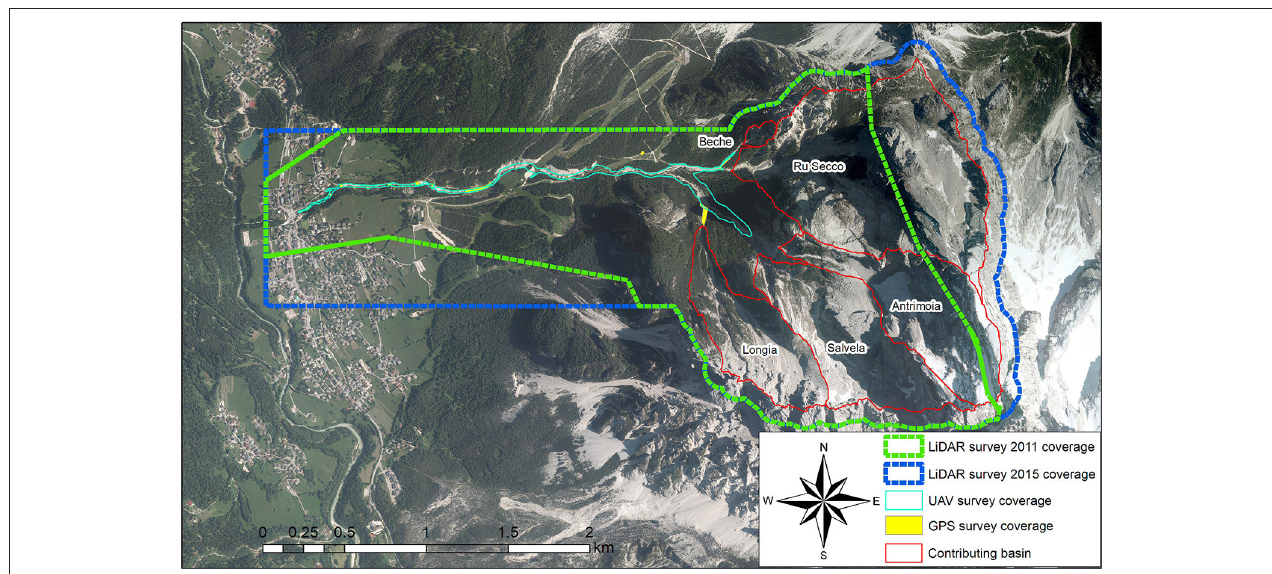
FIGURE 5 | Schematic view of the cover of the topographical